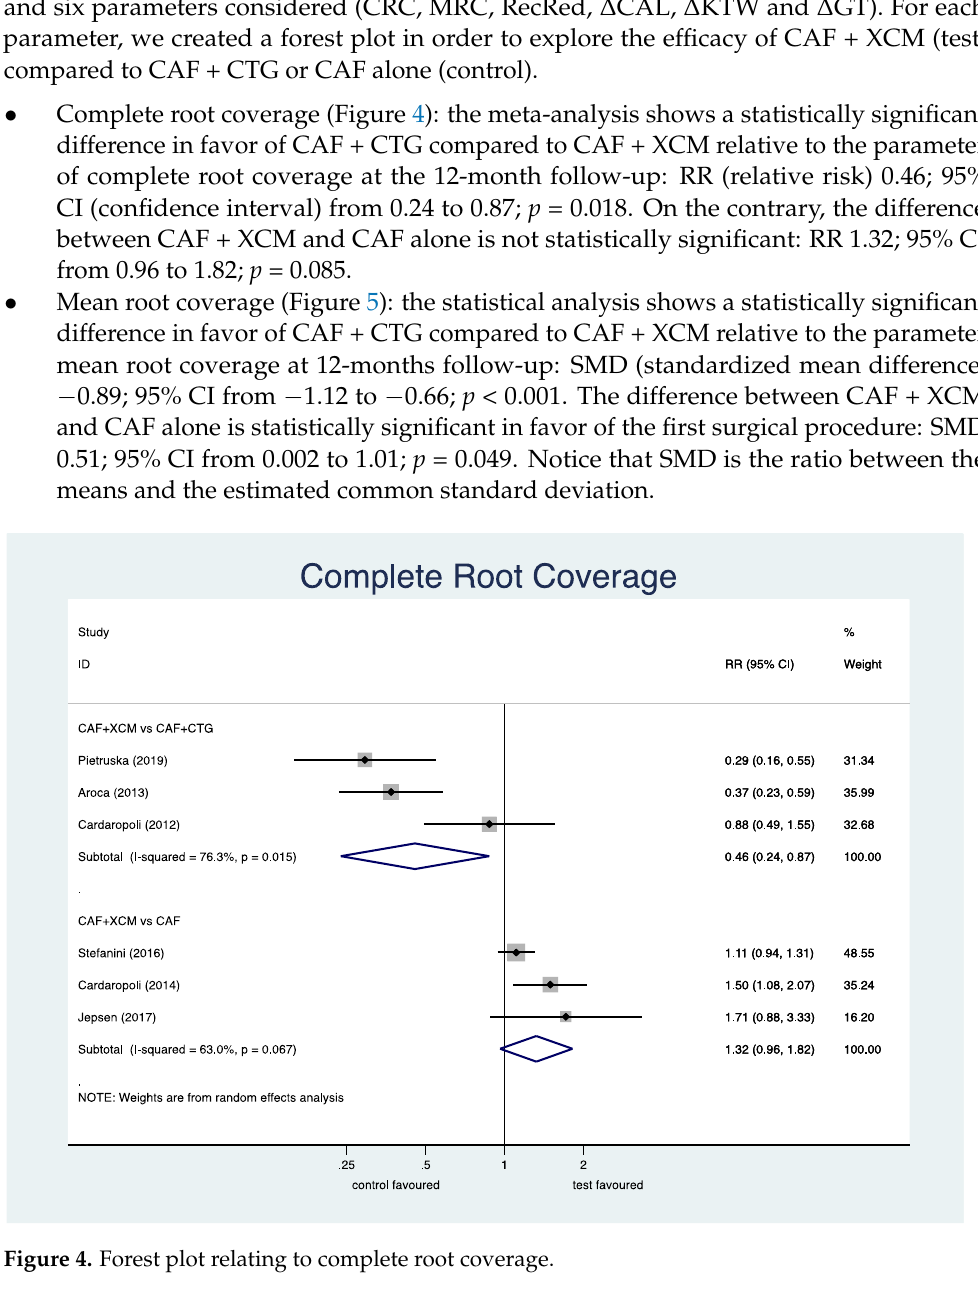
Figure 5. Forest plot relating to mean root coverage.